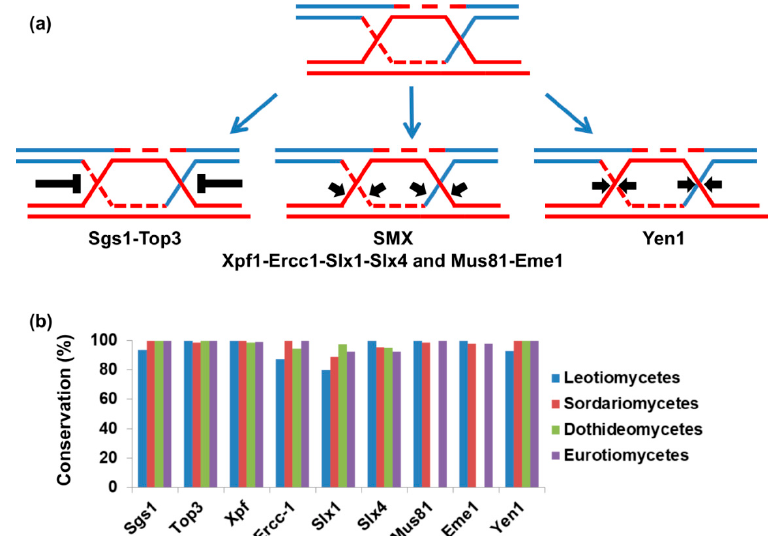
Figure 1. Mechanisms of Holliday junction resolution ( a ). Four evolutionarily